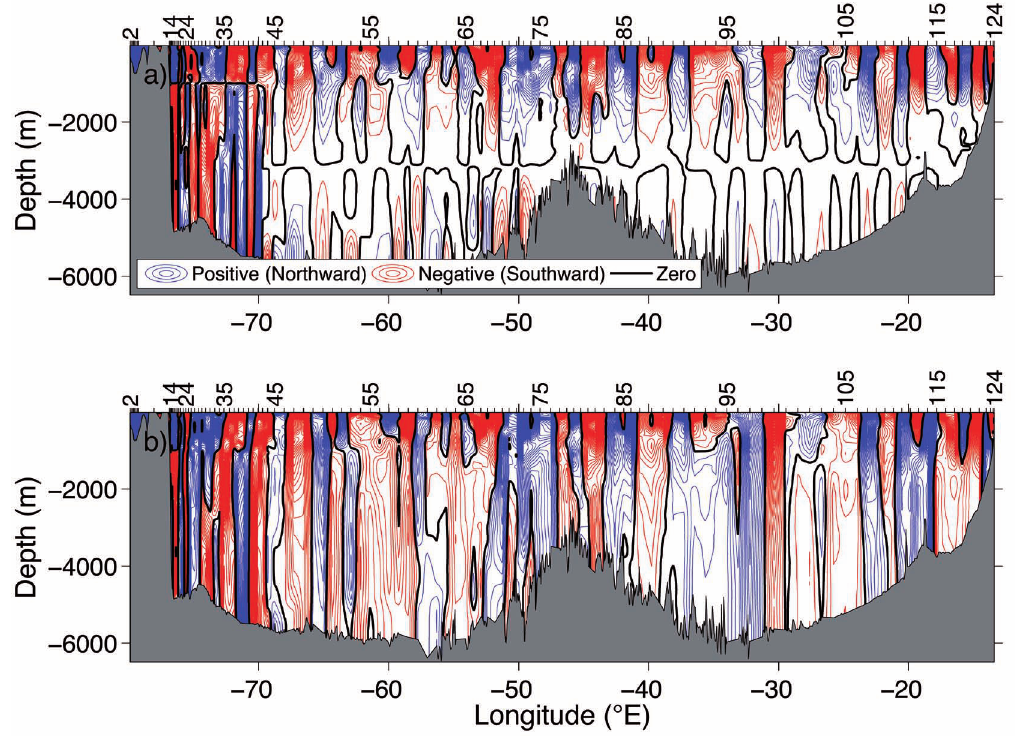
Fig . 7. – Velocity fields (cm s -1 ) contoured a) before and b) after the correction that applied ADCP